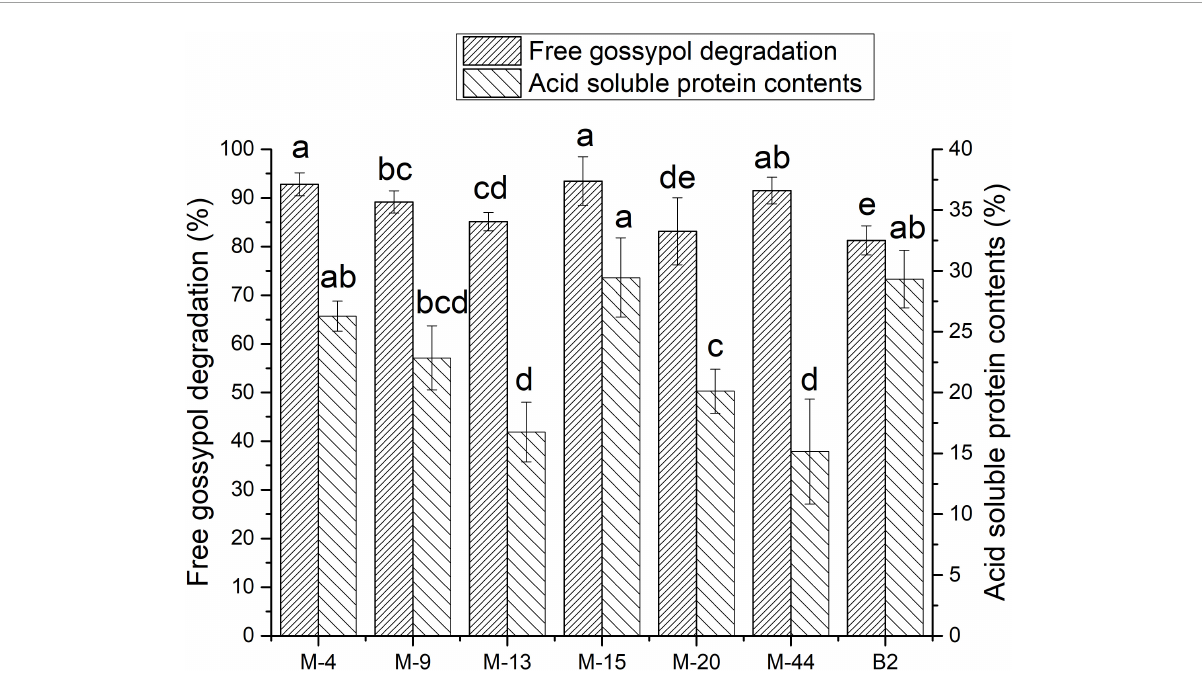
TABLE 1 Similarity of the sequences of 16S rDNA between strain M-15 and reference strains.